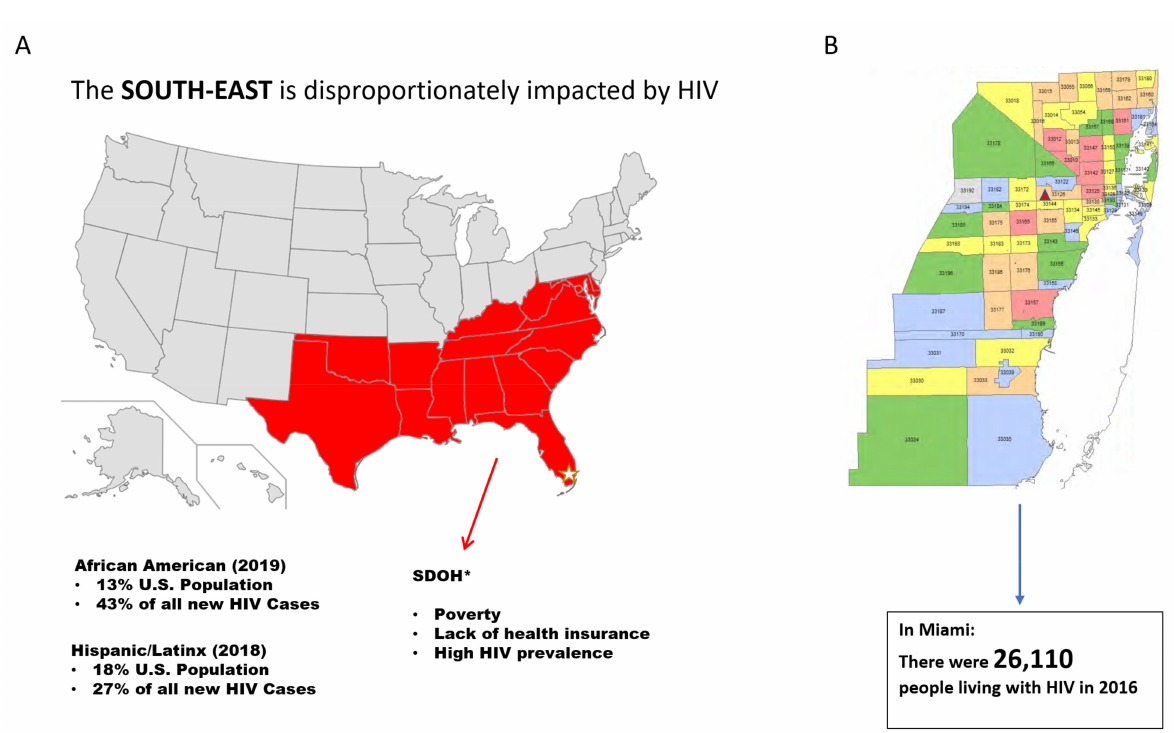
Figure 1. The importance of studying people living with HIV. ( A ). United States map highlighting southeastern states (red). Yellow Star indicates Miami Dade County, in the State of Florida. SDOH* Social Determinants of Health. ( B ). Miami-Dade County by zip codes, the red triangle indicates the location of the Miami International